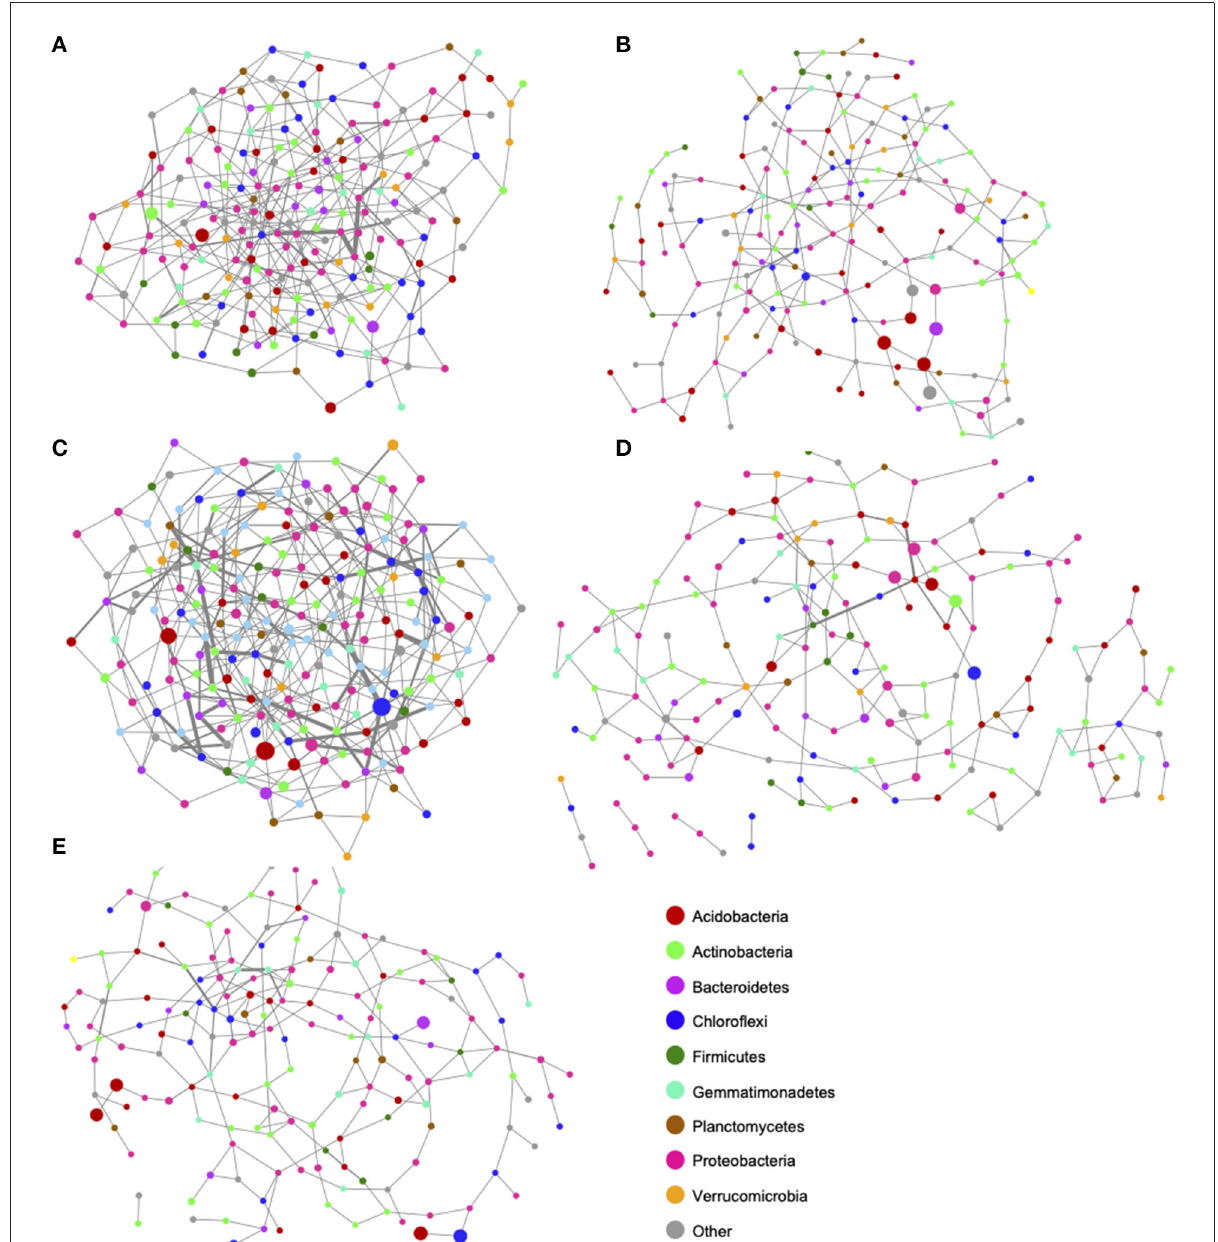
FIGURE4 Co-occurrence networks of bacterial communities across five cover crop treatments and controls. (A) Cool Season, (B) Warm Season, (C) Cool/Warm Season mix, (D) Barley, and (E) Fallow. Co-occurrence networks indicate bacterial taxa that frequently occur together in a particular treatment or environment. Network nodes are colored by phylum and node size represents the number of connected taxa. Taxa with many correlations are in the most densely connected areas of the network. Edges (lines connecting nodes) represent significant ( p < 0.05) positive correlations between taxa. thickness is proportional to the correlations between pairwise